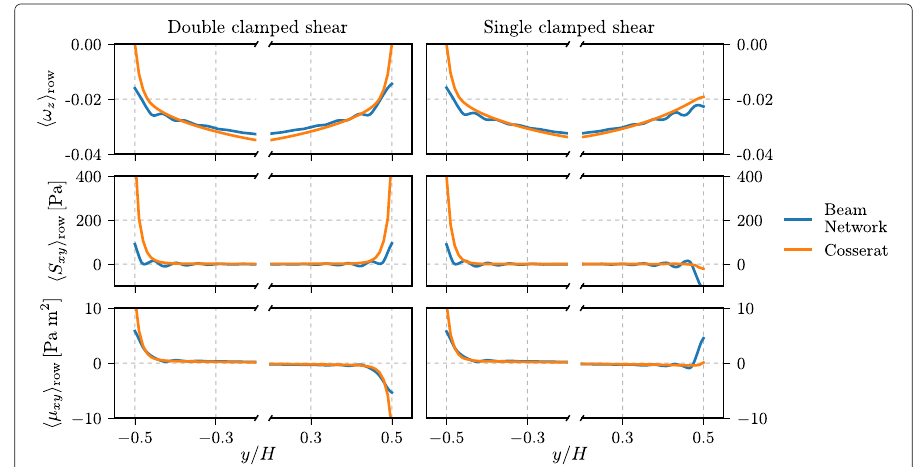
Fig. 6 Rotation, skew-symmetric stress and couple stress profiles under shear with different boundary conditions; parameters as in Fig. 5, center; profiles are obtained by averaging the two-dimensional fields shown in Fig. 5 over the ’horizontal’ direction; left: simple shear loading with fully constrained top and bottom surfaces; right: shear loading with micro-free rotation at the top surface and fully constrained bottom